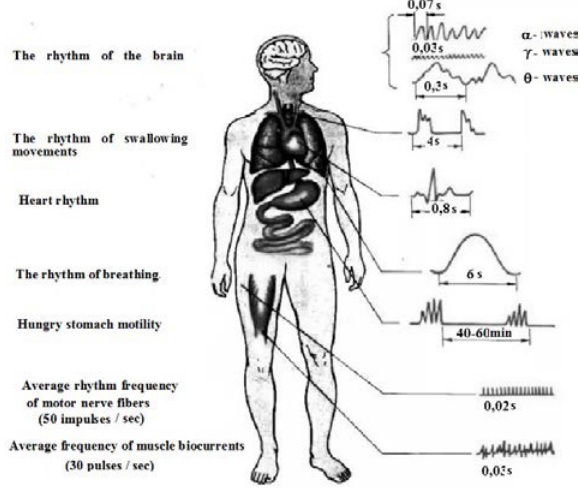
Fig. 1. Rhythm generators in the human